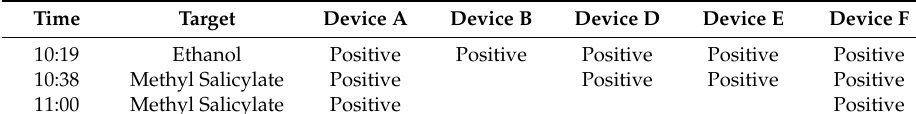
Table 1. Exposure response summary.